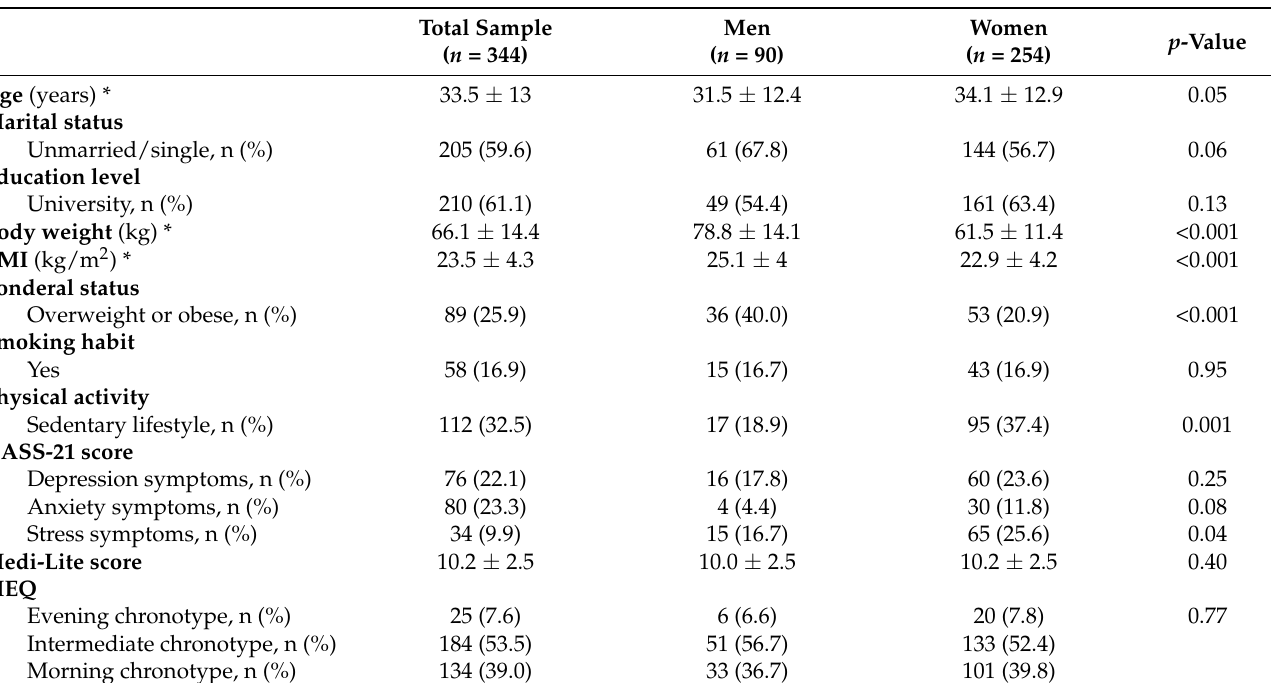
Table 1. Demographic, anthropometric, and lifestyle characteristics of participants in the total sample and according to gender. Total Sample ( n =